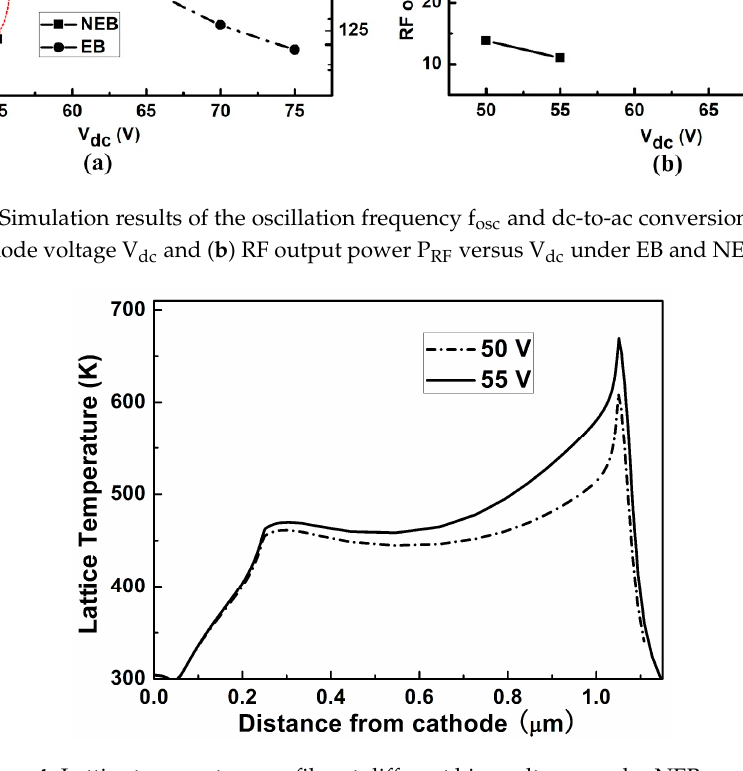
Figure 4. Lattice temperature profiles at different bias voltages under NEB model.